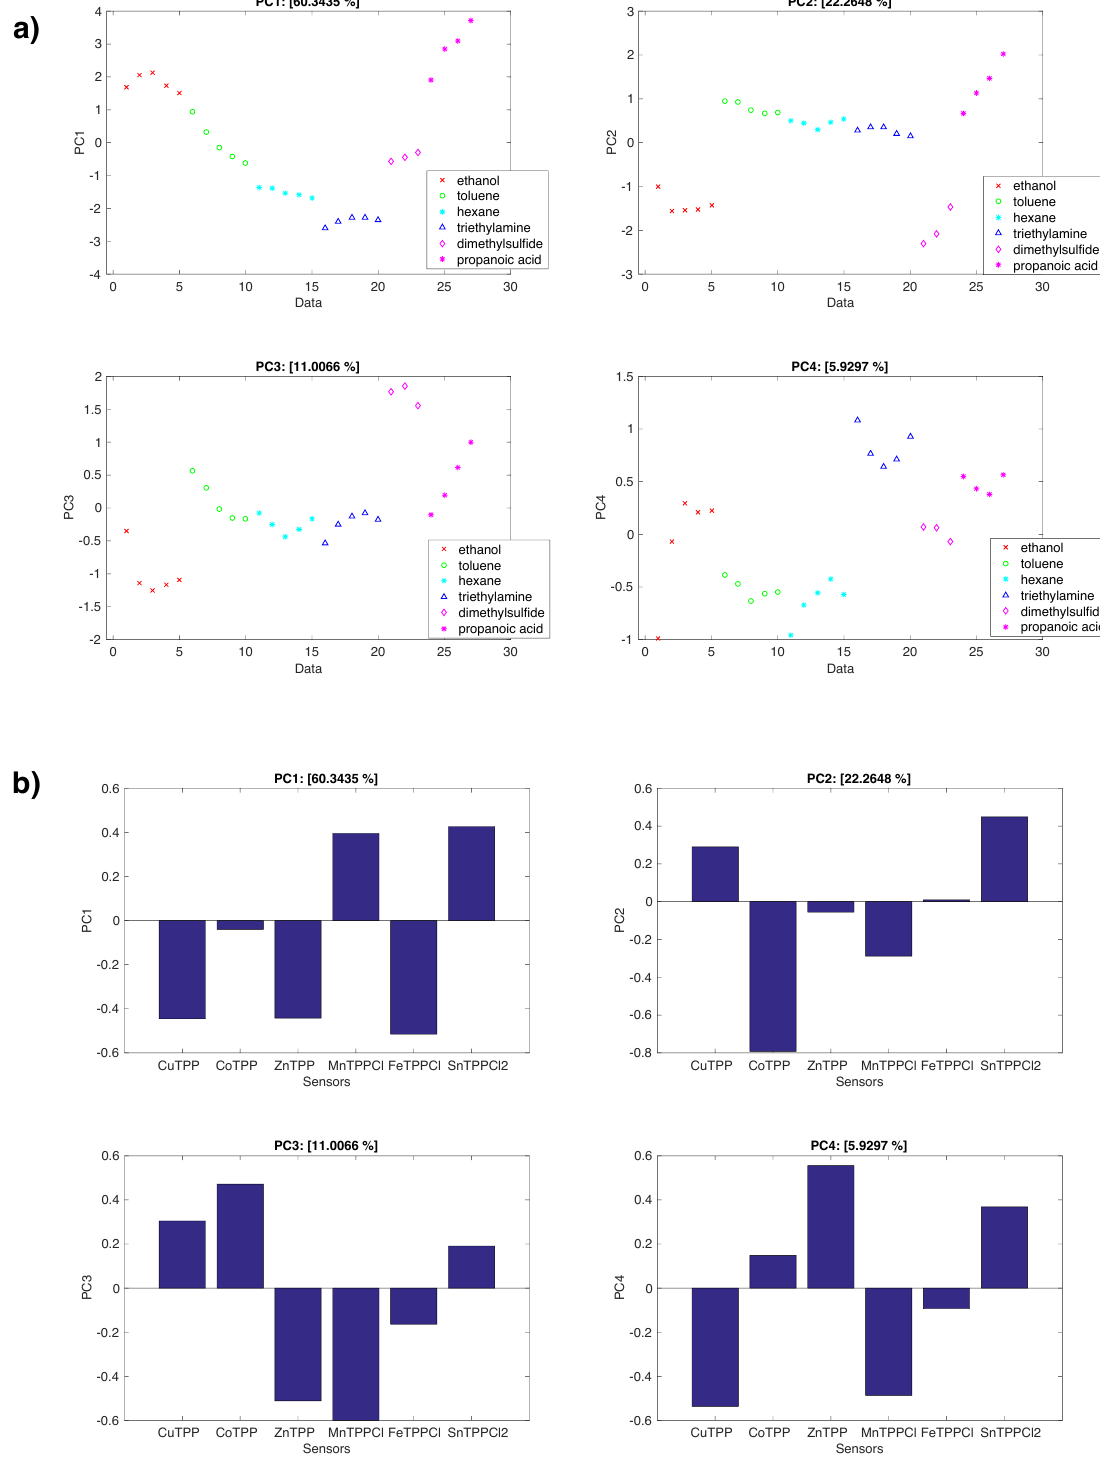
Figure 6. Results of the PCA of the linearly normalized sensors data. ( a ) Scores of the first four principal components; ( b ) Loadings of the first four principal